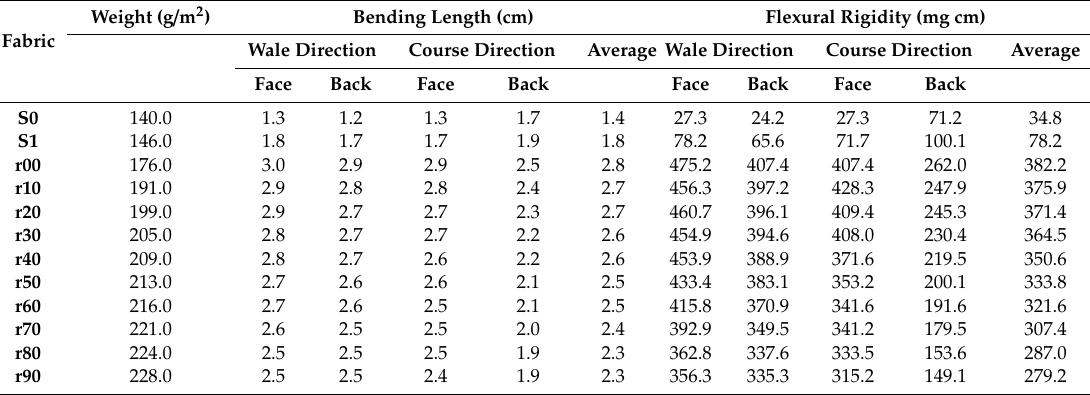
Table 3. Bending length and flexural rigidly results.